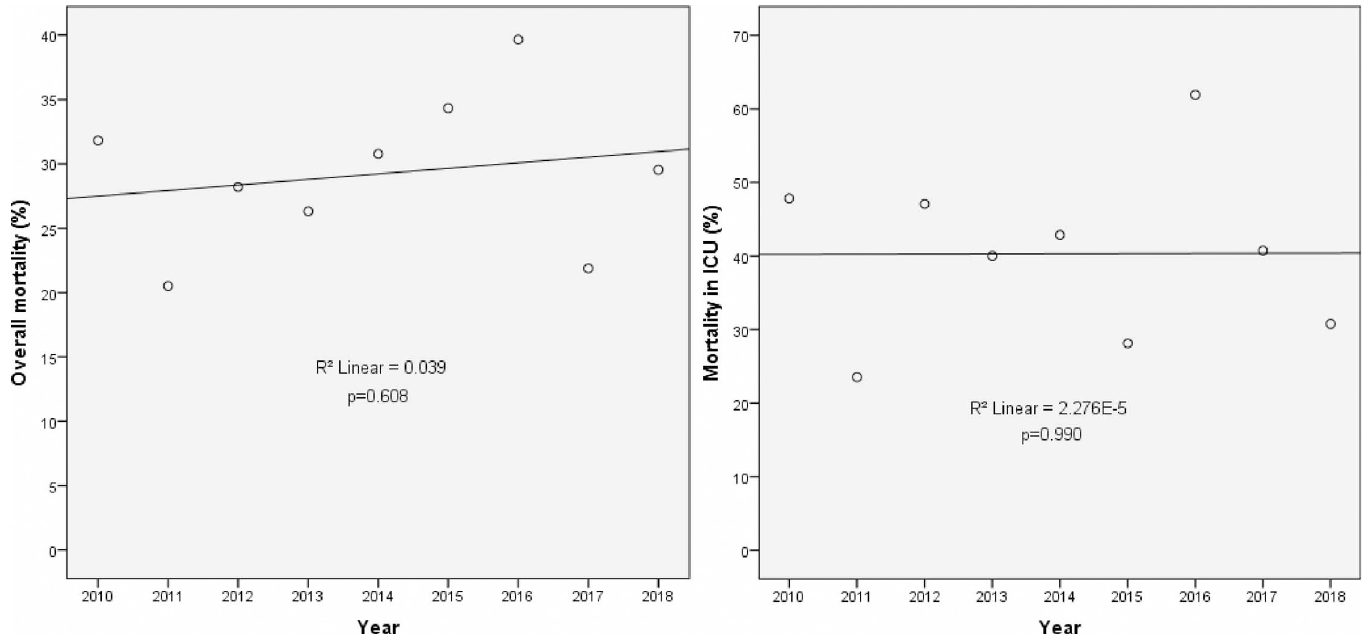
Fig 4. Mortality rate of candidemia over nine years in the overall population (A) and in ICU patients (B).